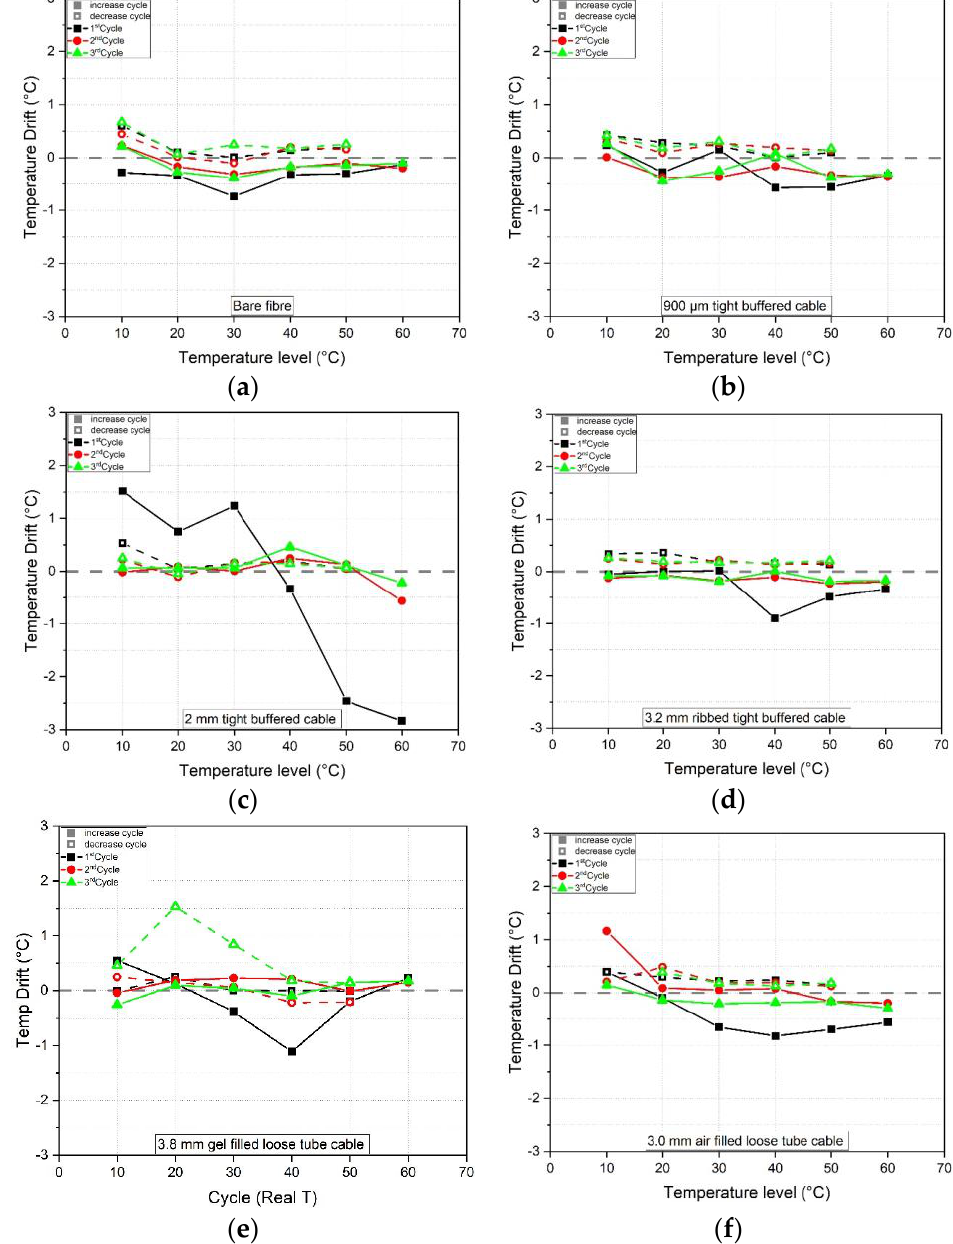
Figure 12. Temperature drift over time at each temperature level (10 – 60 °C) and cycle (1 – 3), ( a ) bare fibre, ( b ) 900 μm tight buffered, ( c ) 2.0 mm tight buffered, ( d ) 3.2 mm ribbed tight buffered, ( e ) 3.8 mm gel filled loose tube and ( f ) 3.0 mm air filled loose tube cable. Table 7. Analysis of humidity and temperature including the max/min drift, max/min peaks along the length and max standard deviation, SD (shown in shaded cells).